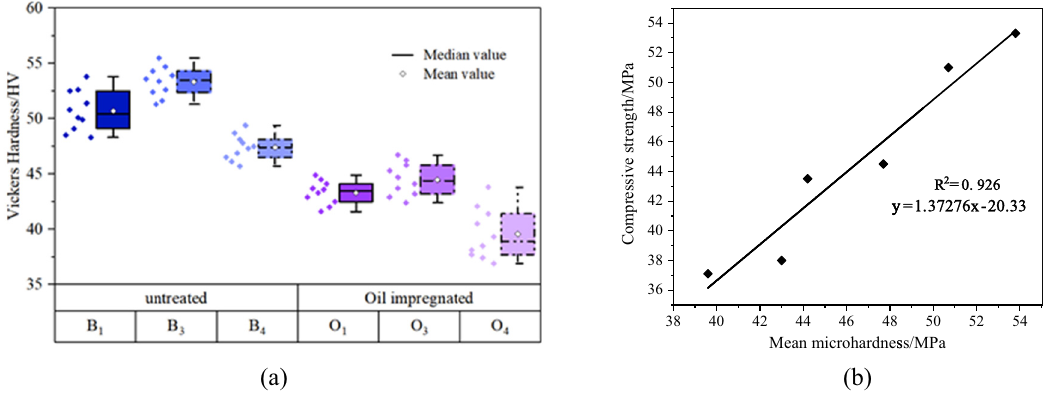
Figure 5: Microhardness and its relationship with compressive strength. ( a ) Microhardness and ( b ) the relationship curve between com - pressive strength and